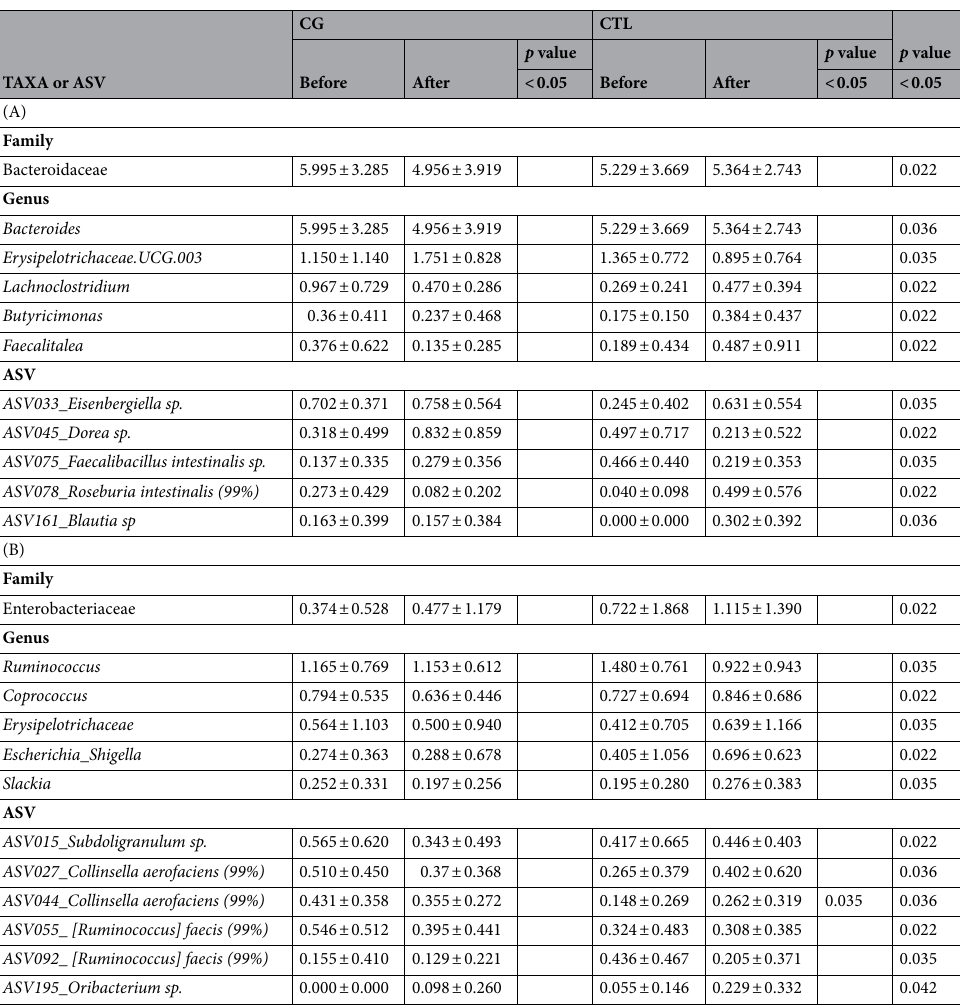
Table 5. Subgroup analysis: Impacted microbial features (n = 13). (A): Impacted microbial features in “High-H 2 ” subgroup. (B): Impacted microbial features in “Low-H 2 ” subgroup. Data are expressed as mean percentage of relative abundance and presented as mean ± SD. To compare the shifts (i.e. the delta between the two treatments) and the baseline and endpoint, Wilcoxon signed-rank tests were performed and considered as significant if p < 0.05. For ASV identification, species name is indicated when the identity is >